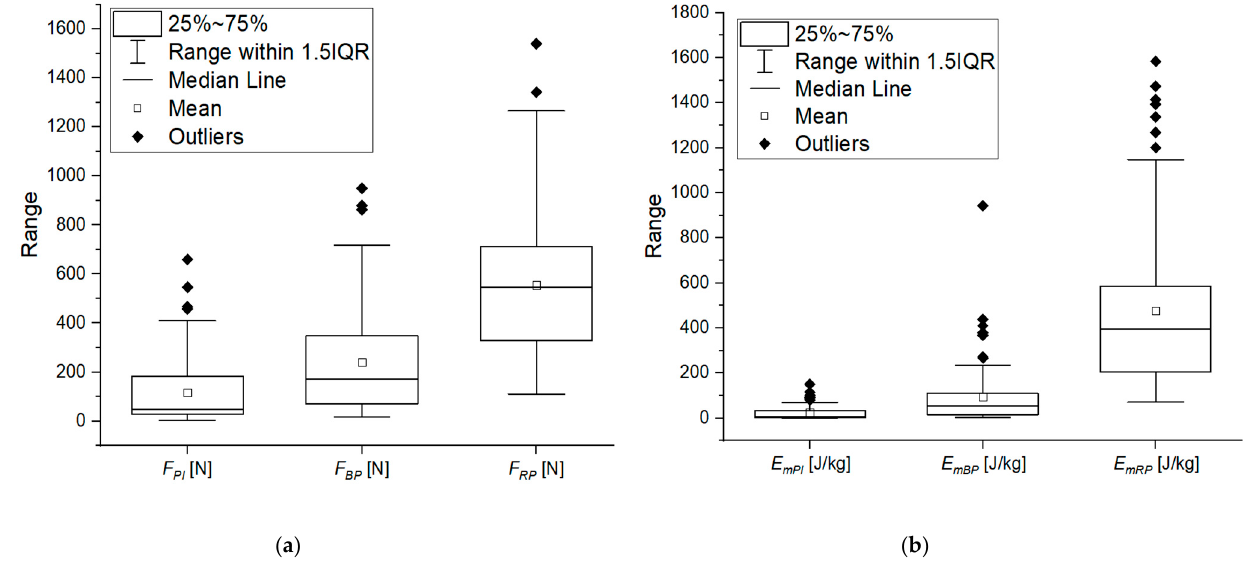
Figure 7. The force-deformation curve representing the cracking process for corn grains.